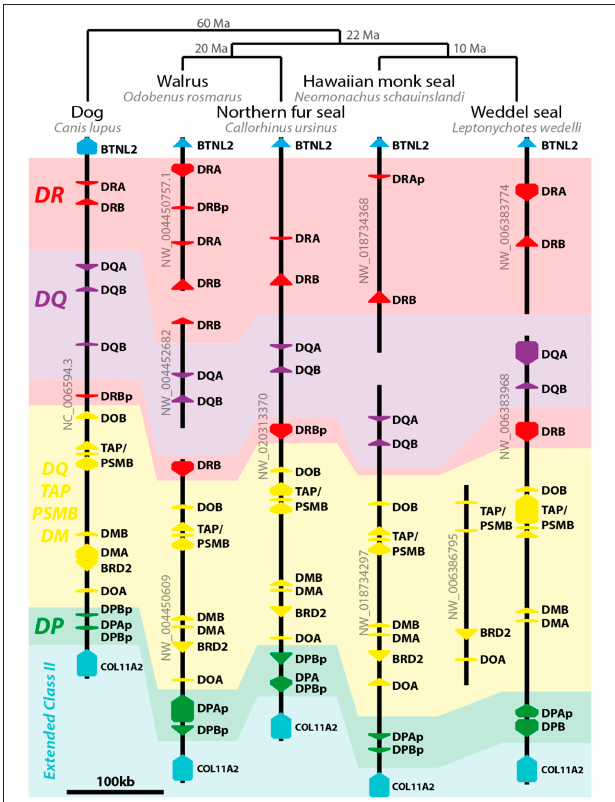
FIGURE 3 | Model of pinniped class II MHC evolution. On the top of image, the pinniped phylogeny and divergence time (Ma, million years before present) proposed by Nyakatura and Bininda-Emonds (40). On the left, dog class II MHC region is depicted as an outgroup and model of the Carnivora genome organization. Arrows represent genes and pseudogenes (shown as “p” in the end of the gene’s name). Only informative scaffolds of the MHC structure are displayed. In color, a schematic view of class II loci helps to understand the evolution of class II loci ( DR —red; DQ —purple; DP —green; DO/TAP/PSMB/DM —yellow). TAP/PSMB represents TAP1 , TAP2 , PSMB8 , PSMB9 .